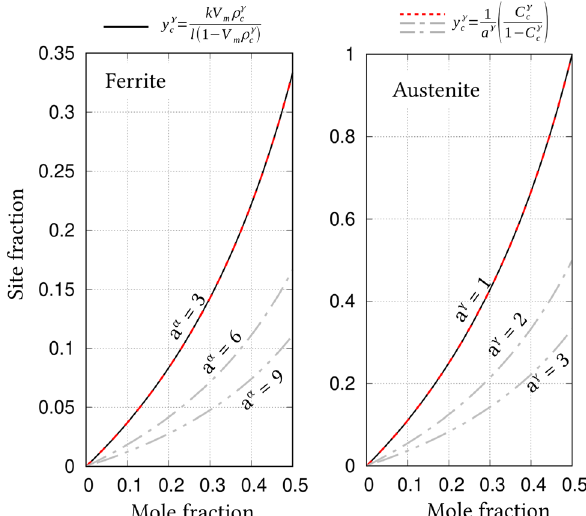
Figure 1. Relation between site- and mole-fraction, in ferrite and austenite, estimated based on Eqs. (13) and (52). Constant, a (cid:31) , involved in Eq. (13), varies with the permissible interstitial‑sites consideration . When carbon atoms are assumed to occupy octahedral, tetrahedral and all sites of interstitial lattice, in ferrite, the 3 , 6 and 9, on the other hand, in austenite, it changes to constant correspondingly adopts the value of a (cid:31) = a (cid:31) 1 , 2 and 3, respectively. In both ferrite and austenite, sublattice stoichiometry is recovered when the = permissible interstitial-sites are confined to octahedral